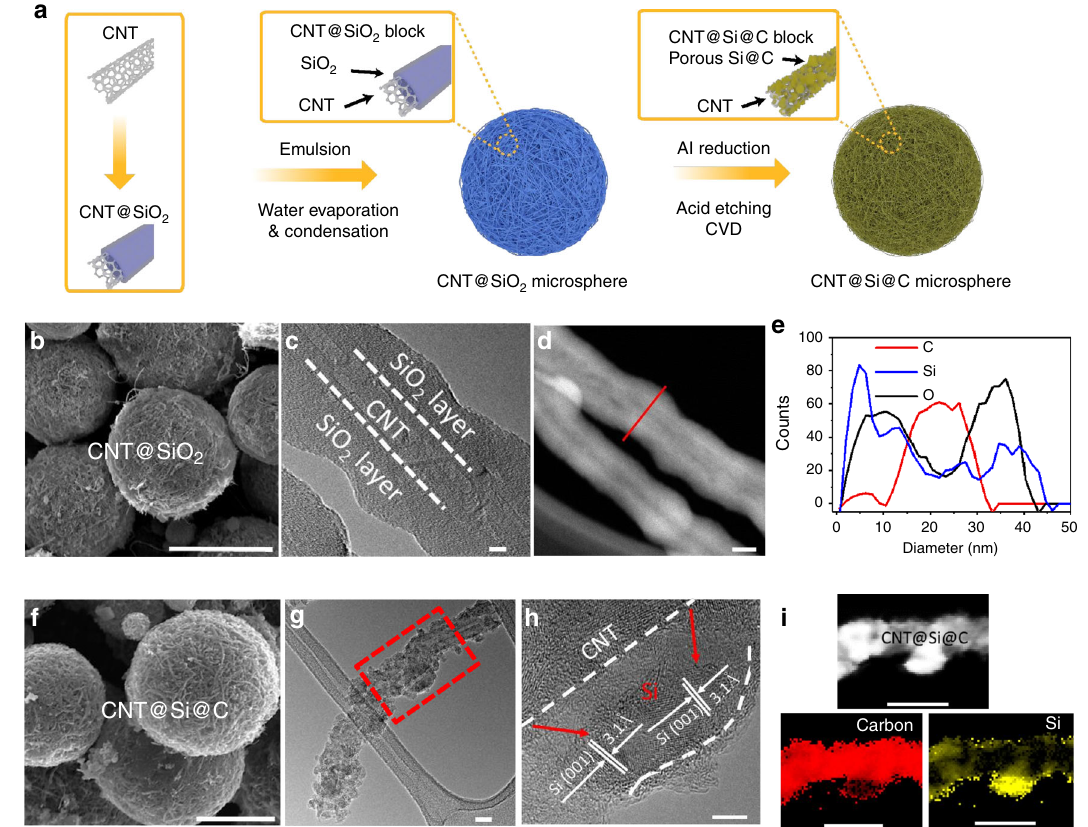
Fig. 1 Schematic of synthesis process and structural characterization of the key intermediate products of CNT@SiO 2 and fi nal CNT@Si@C microspheres. a Schematic fi gure showing the synthesis of CNT@Si@C microspheres. b A typical SEM image of CNT@SiO 2 microspheres (scale bar = 5 µ m). c A representative TEM image of a CNT@SiO 2 core-shell coaxial cable (scale bar = 5 µ m). d A STEM image of the CNT@SiO 2 cables (scale bar = 20 µ m). e EDS line scan of the CNT@SiO 2 cable marked in d . Small discrepancy of Si and O due to beam effect from prolonged scanning. f A typical SEM image of CNT@Si@C microspheres (scale bar = 3 µ m). g Low-magni fi cation TEM image of a composite cable from a CNT@Si@C microsphere (scale bar = 20 µ m), h HRTEM image of the cable in g (scale bar = 5 µ m). i EDS mapping of the marked area in g (scale bar = 50 µ